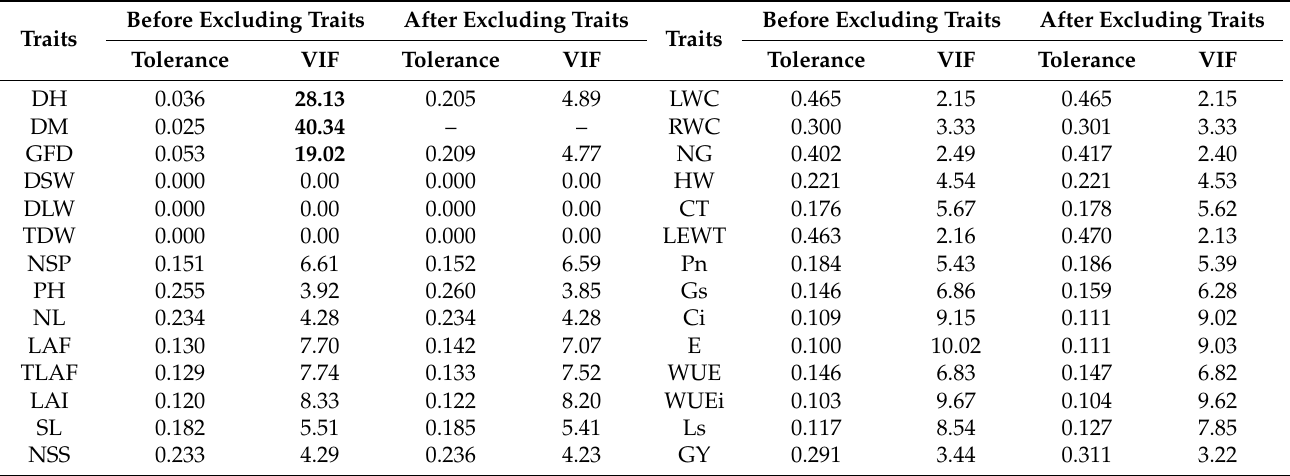
Table 4. Multicollinearity diagnosis (tolerance and variance inflation factor) of Pearson product-moment correlation matrix for 28 measured traits.